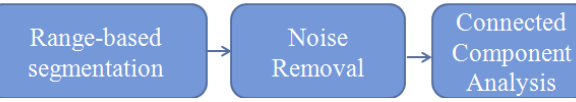
Figure 4. Multiple-step range based